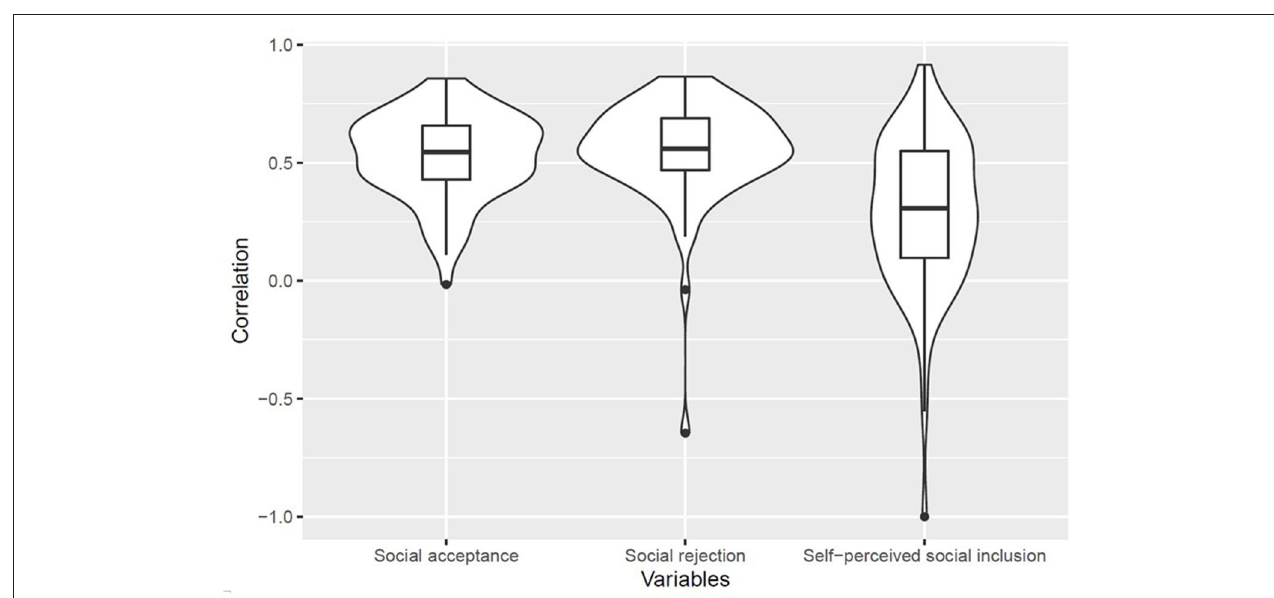
FIGURE 2 | Distribution of correlations between teacher ratings and students’ attributes for three criteria of social inclusion. For an explanation of the boxplots, see Figure 1